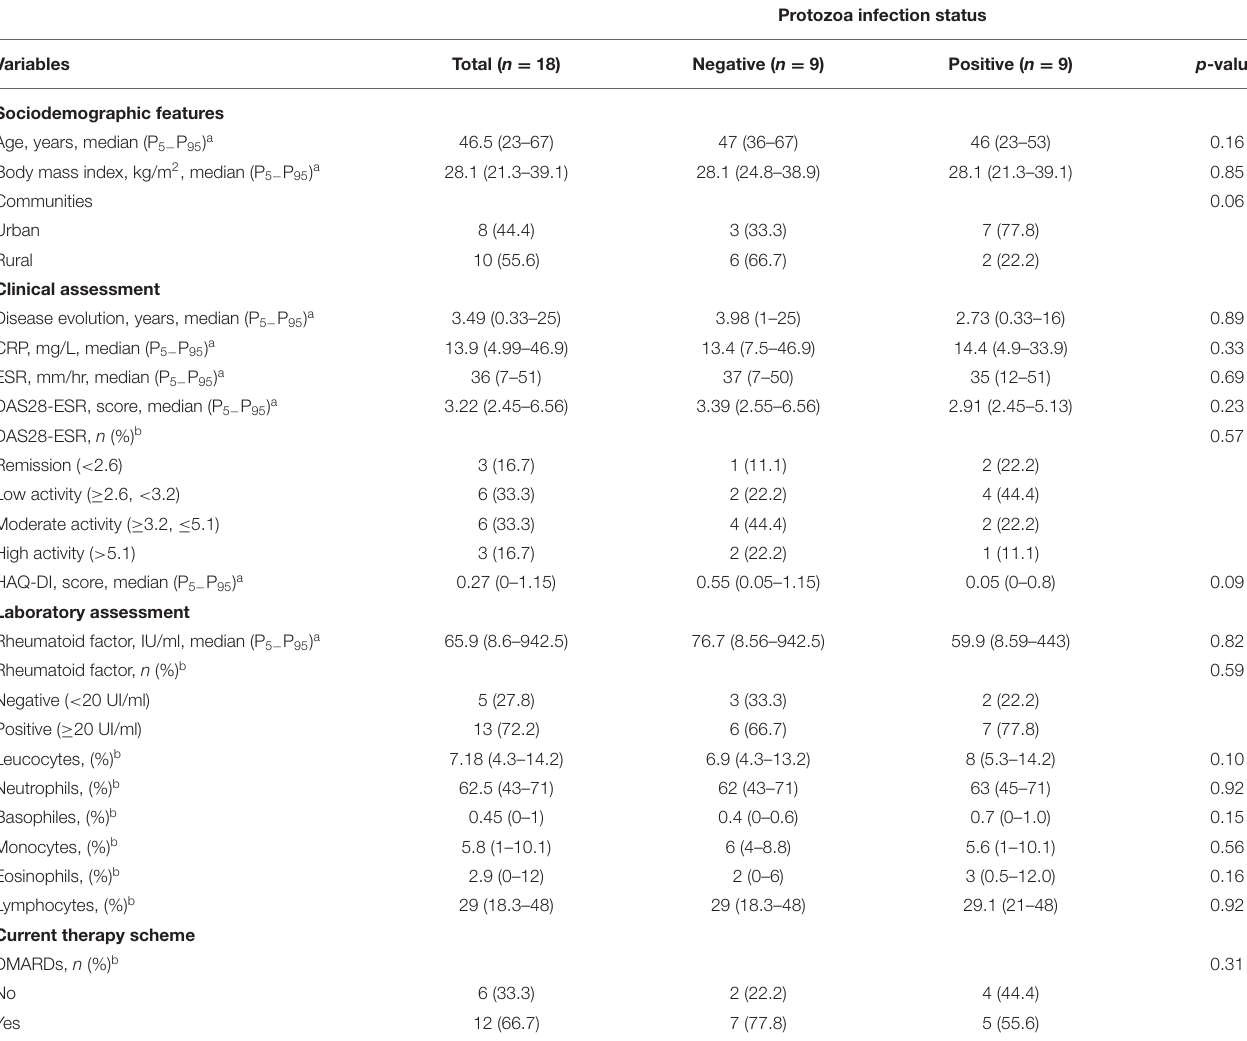
TABLE 1 | Demographic, clinical, and inflammatory parameters according to the infection status by intestinal protozoa in patients with